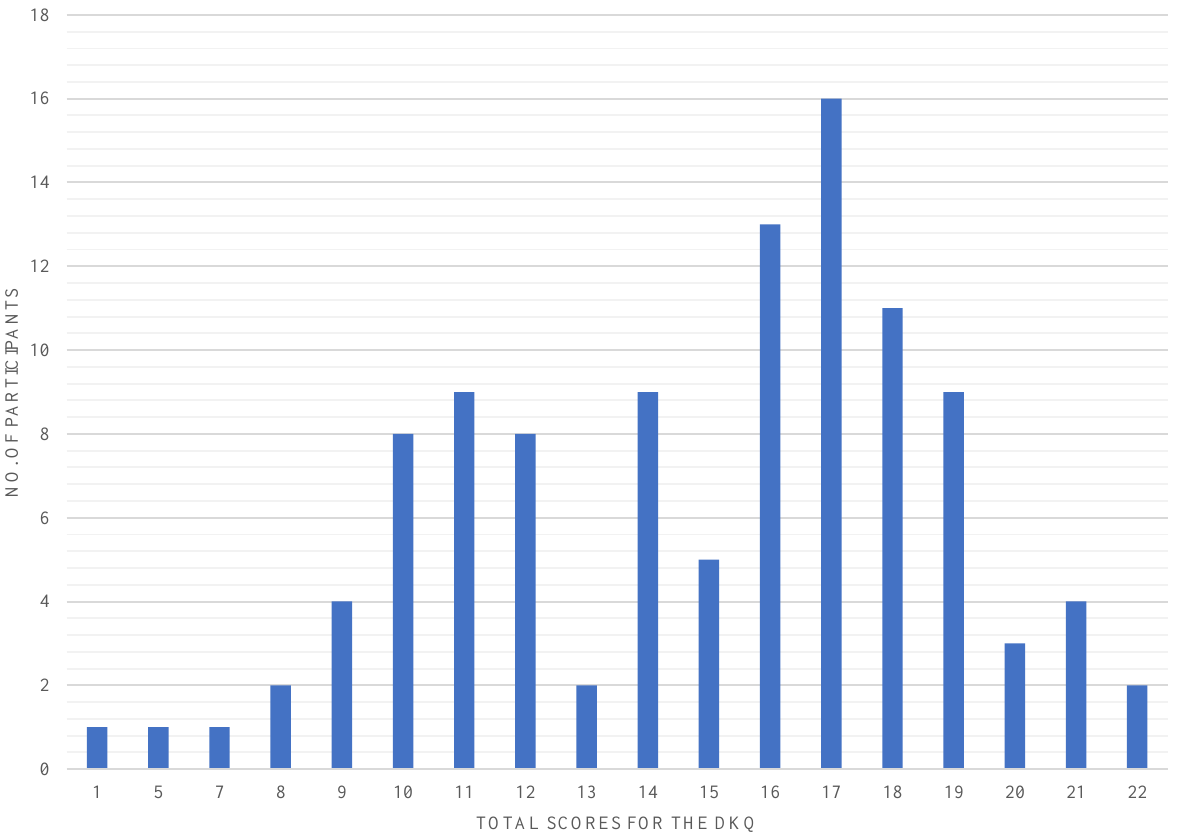
Figure 1. Distribution of number of participants and their total scores for the diabetes knowledge questionnaire.